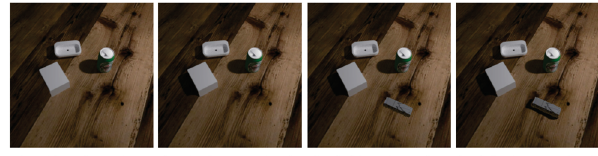
Fig. 6 Shadow synthesis for the same scene and illumination, with a slightly rotated camera. Top row: input scenes, bottom row: corresponding synthetic results. Fig. 7 Inserting virtual objects in